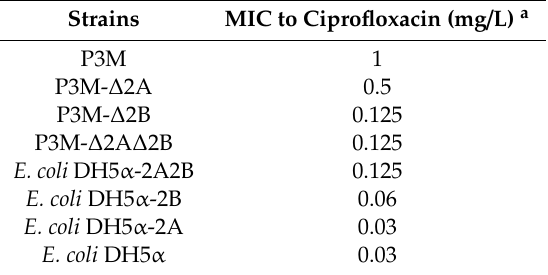
Table 2. Determination of the MIC of ciprofloxacin in di ff erent transformants with respect to the parental